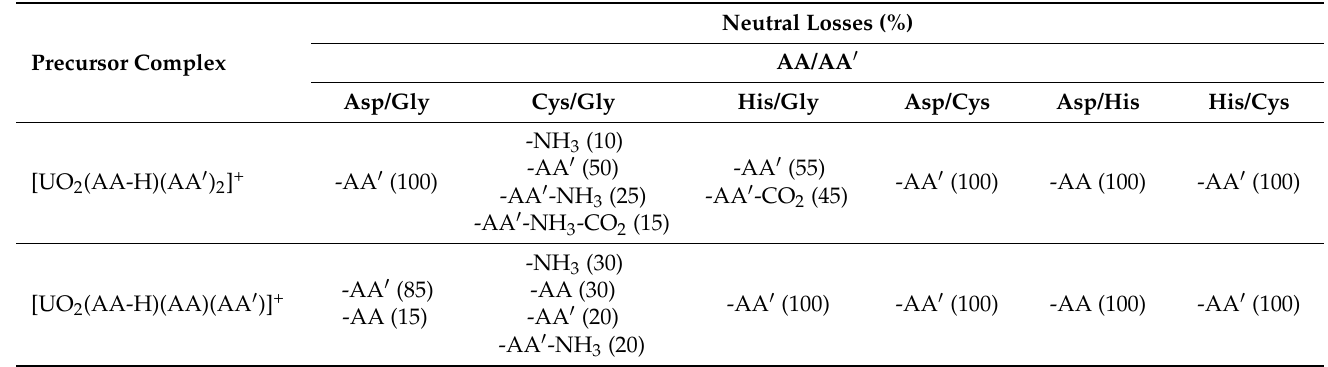
Table 3. Competitive CID of cationic uranyl–amino acid complexes.